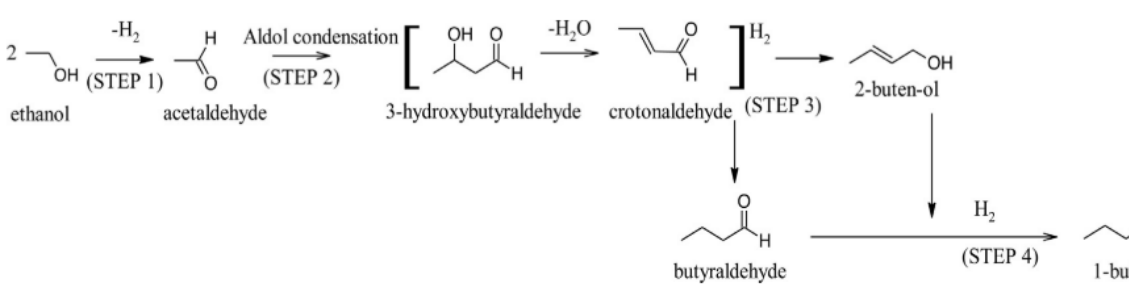
Figure 2. The reaction mechanism of n-butanol formation [45].